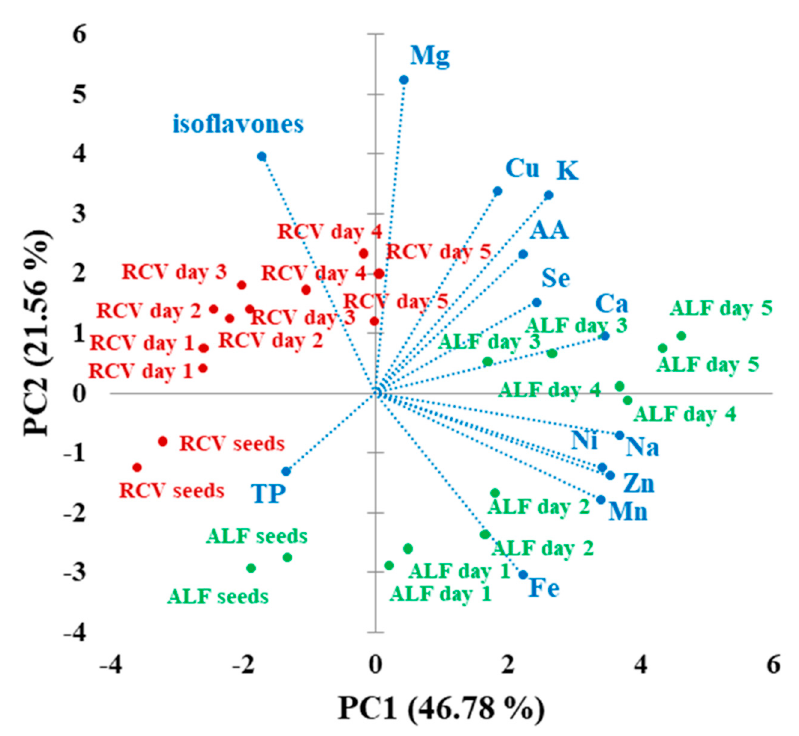
Figure 4. Principal Component Analysis (PCA) of the RCV and ALF sprouts samples during 5 days of germination based on total polyphenols (TP), anti-radical activity (AA), and the sum of isoflavones with estrogenic activity and elemental profile composition.